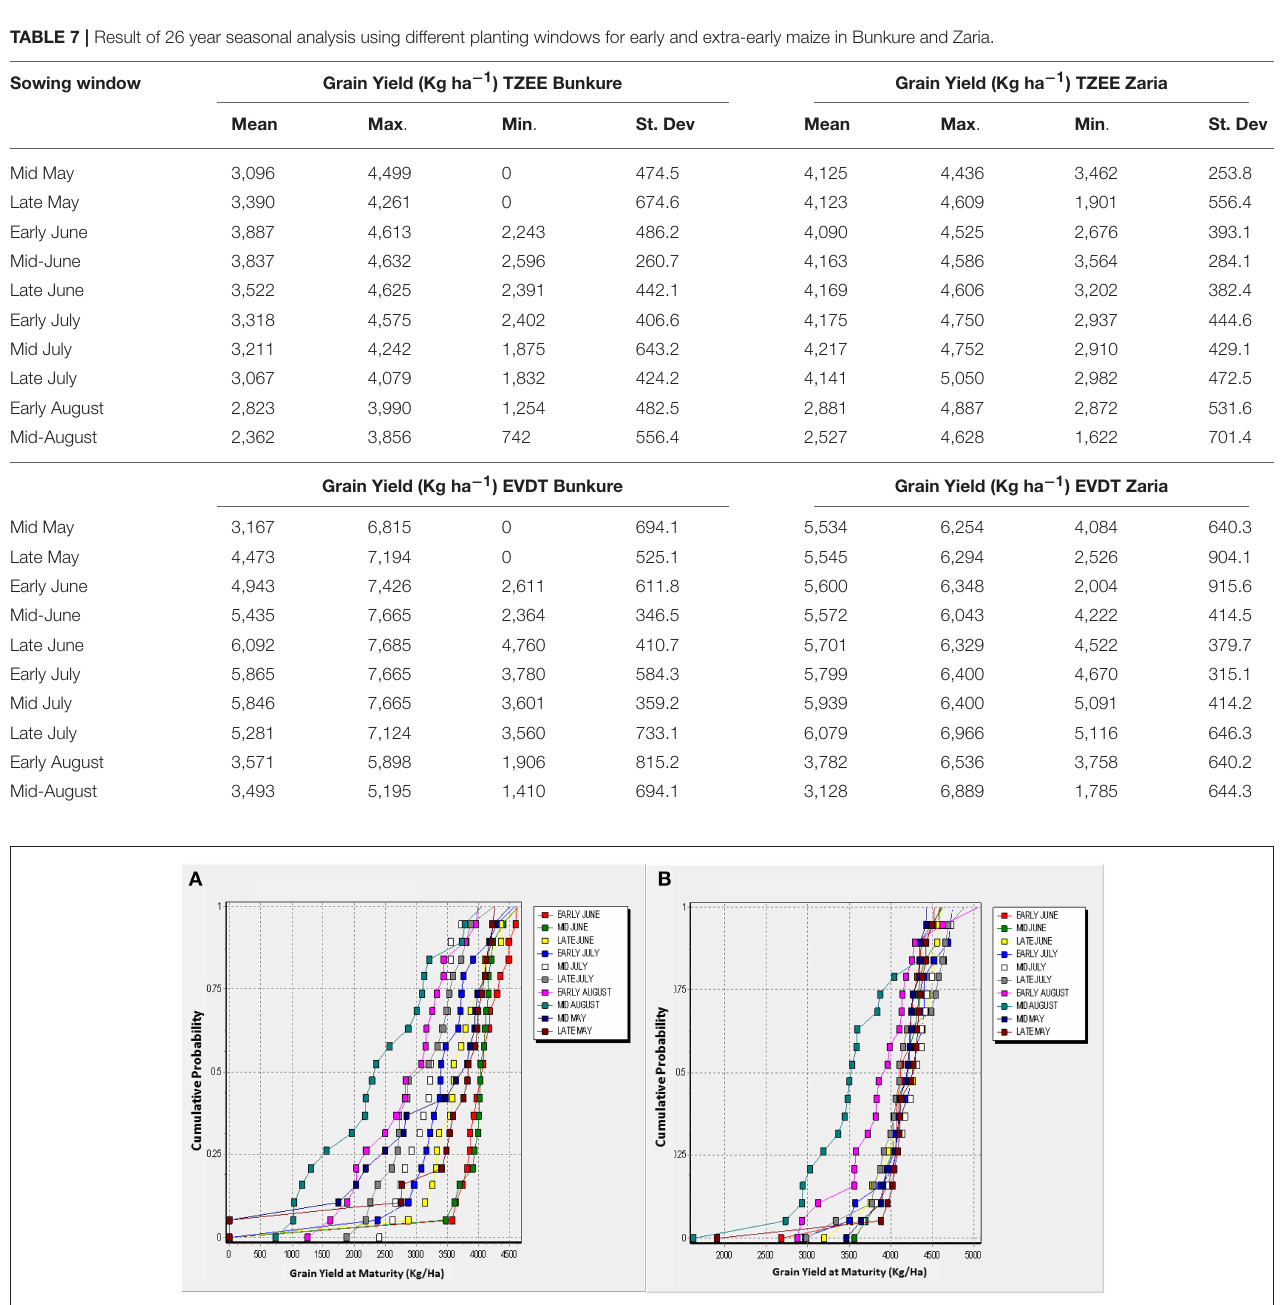
FIGURE 5 | Cumulative function plots for simulated grain yields of TZEE in Bunkure (A) and Zaria (B)